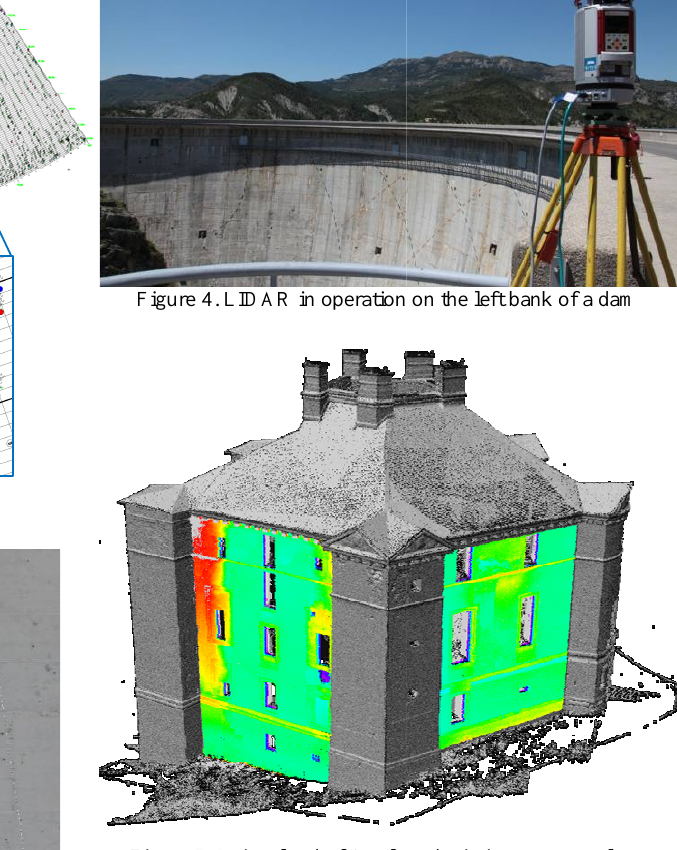
Figure 5. Point cloud of Castle